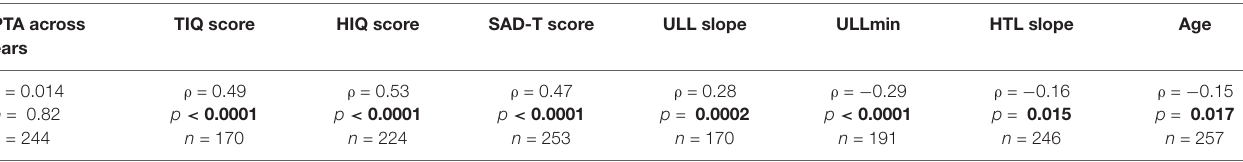
TABLE 4 | Spearman correlations ( ρ ) and corresponding p values between the number of days out of 14 when bothered by certain sounds (based on SSSQ4 score) with: PTA (pure tone average) across ears, TIQ (Tinnitus Impact Questionnaire) scores, HIQ (Hyperacusis Impact Questionnaire) scores, SAD-T (Screening for Anxiety and Depression-Tinnitus) scores, ULL slope (the value of the difference in ULLs between 8 and 1 kHz) for each ear and averaged across ears, ULLmin (across-frequency average uncomfortable loudness level for the ear with lower average ULL), HTL slope (value of the differences in hearing threshold levels between 8 and 1 kHz) for each ear and averaged across ears, and